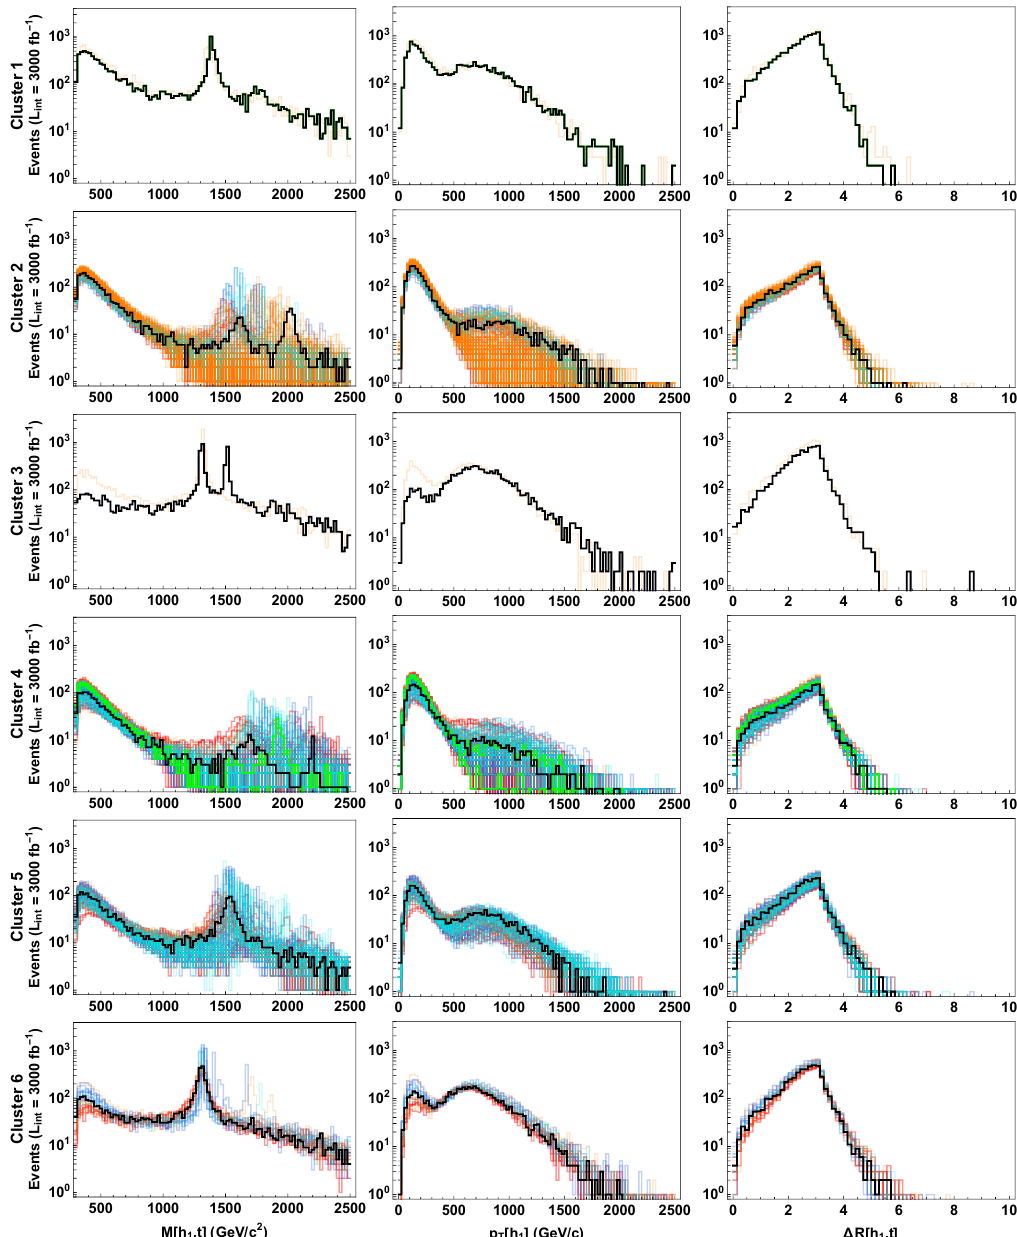
√ Figure 22 . Distributions at s = 14 TeV for the invariant mass of the pair composed by top and most energetic Higgs h 1 (first column), transverse momenta of h 1 (second column) and angular distances in the transverse plane between h 1 and the top (third column), organized in clusters by similarity (clusters 1 through 6). Red, blue, orange and cyan curves indicate respectively points in Regions I, II, III and IV of the MCHM 14 . The benchmark point for each cluster is shown in black, with clusters 1 to 6 containing respectively points D 1 to D 6 in table 6 of the main article. The example points (table 2 is the main article) are shown in green (cluster 1 contains Q 1 , cluster 4 contains Q 5 and Q 7